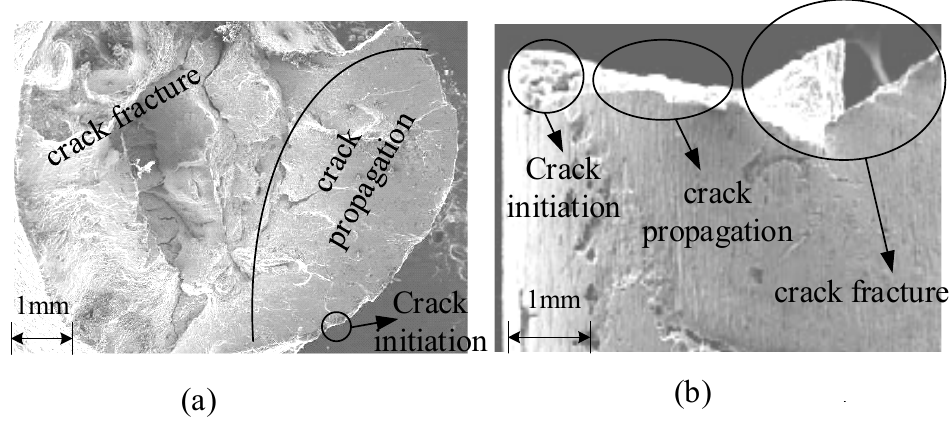
Figure 6. Corrosion fatigue fracture morphology. ( a ) Corrosion pit evolution diagram; ( b ) steel wire fracture diagram near corrosion